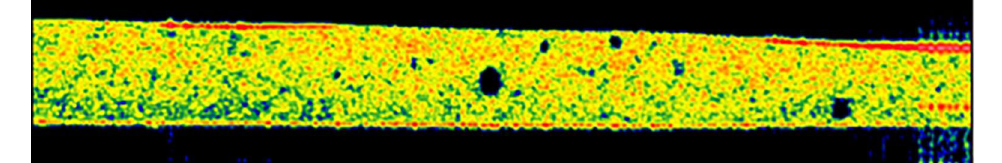
FIGURE 3 - Tomographic image of the emulsified system ES-1, without dispersion in purified